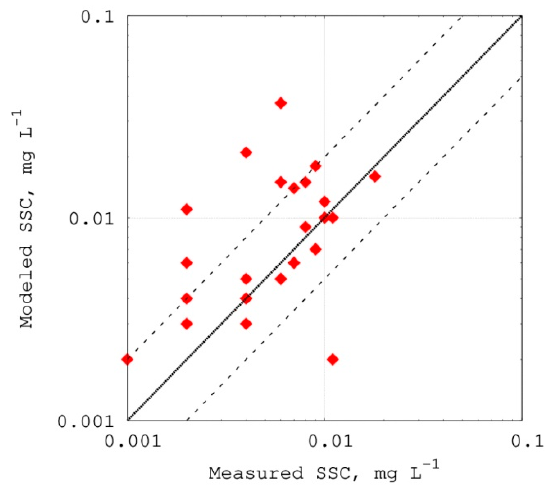
Figure 7. Scatterplot of the sediment transport model validation plotted on a logarithmic scale. Solid line indicates absolute agreement with the measurements, dashed lines corresponds to the endpoints of double relative discrepancy intervals. Data are sampled in 15 different places during August–September, 2016.